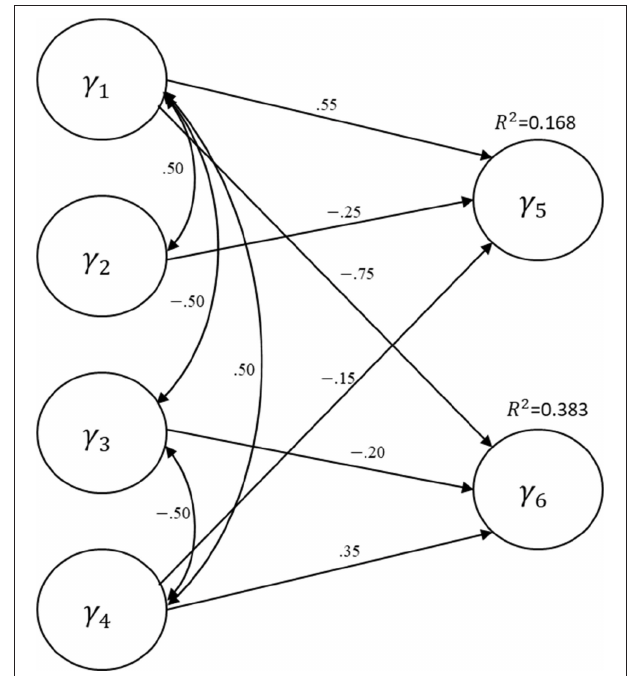
FIGURE 1 | The population structural equation model specified for the simulation